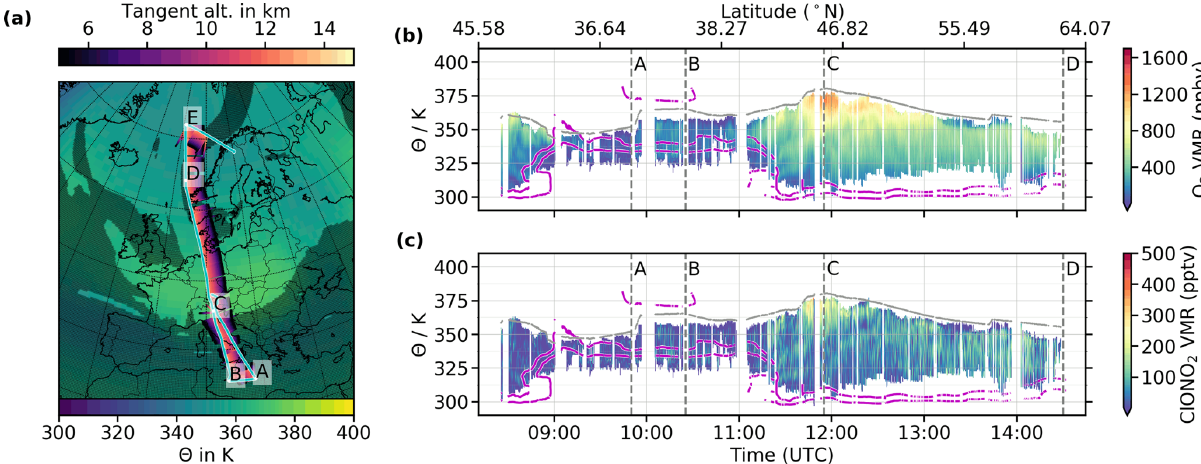
Figure 5. Flight PGS06 (12 January 2016): (a) flight path (cyan) on a map with MERRA-2 potential temperatures (lower color bar) at a typical HALO cruise altitude of 13km. Regions outside the polar vortex (at θ = 370K, according to Nash et al. (1996)) are marked with a grey shadow. Waypoints are marked with capital letters. The tangent altitudes of GLORIA measurements are shown in the upper color bar. Right panels: GLORIA cross section of (b) O 3 and (c) ClONO 2 (using GLORIA potential temperature). The flight level (approximated using MERRA-2 potential temperature) is marked with a grey line and white spaces mark regions without data. The MERRA-2 potential vorticities of 2 and 4PVU are marked with magenta lines, and waypoints are marked with vertical dashed grey lines. Color bars with top and/or bottom arrowheads indicate data greater or smaller than the color bar range. The underlain map (bold black lines show coastal lines, regular black lines country borders, and dotted lines indicate a latitude by longitude grid) shows the European continent and is centered at 50 ◦ N latitude and 10 ◦ E